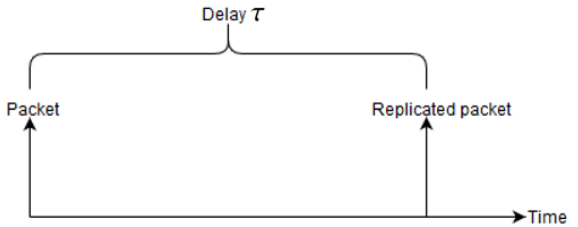
Figure 2. Illustration of how the replicated is withheld by τ .